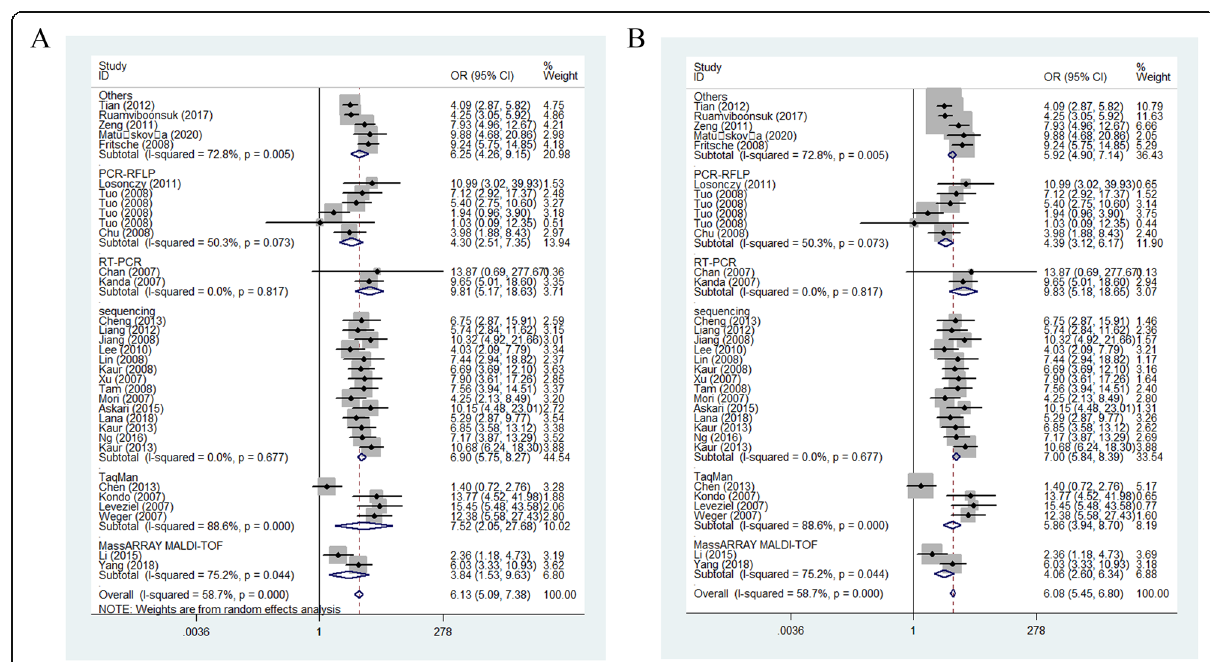
Fig. 7 Forest plot of AMD risk associated with HTRA1 gene rs11200638 polymorphism (AA vs. GG) by genotyping methods subgroup. a : random model; b : fixed model